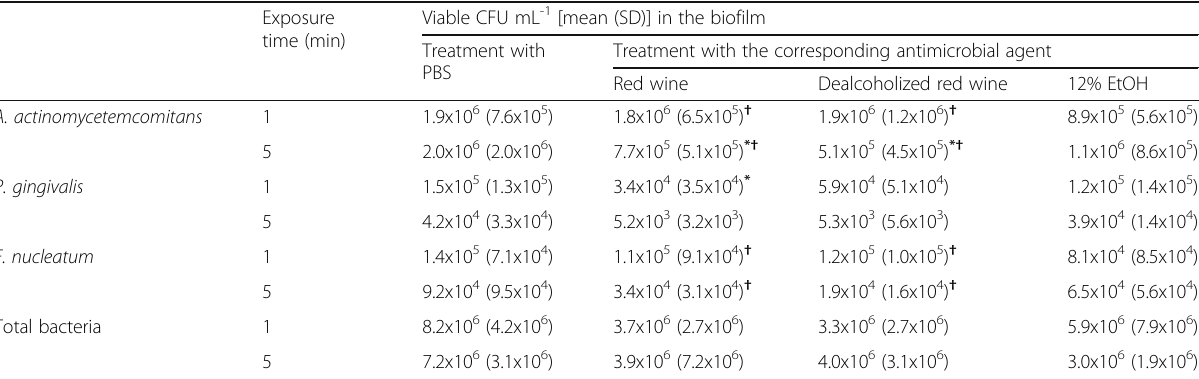
Table 1 Effect of red wine and dealcoholized red wine on the number of viable bacteria in the in vitro multi-species biofilm [colony forming units, CFU mL − 1 , obtained by quantitative real-time polymerase chain reaction (qPCR)]. Data are expressed as mean ± standard deviation (SD). PBS: phosphate buffer saline, EtOH: